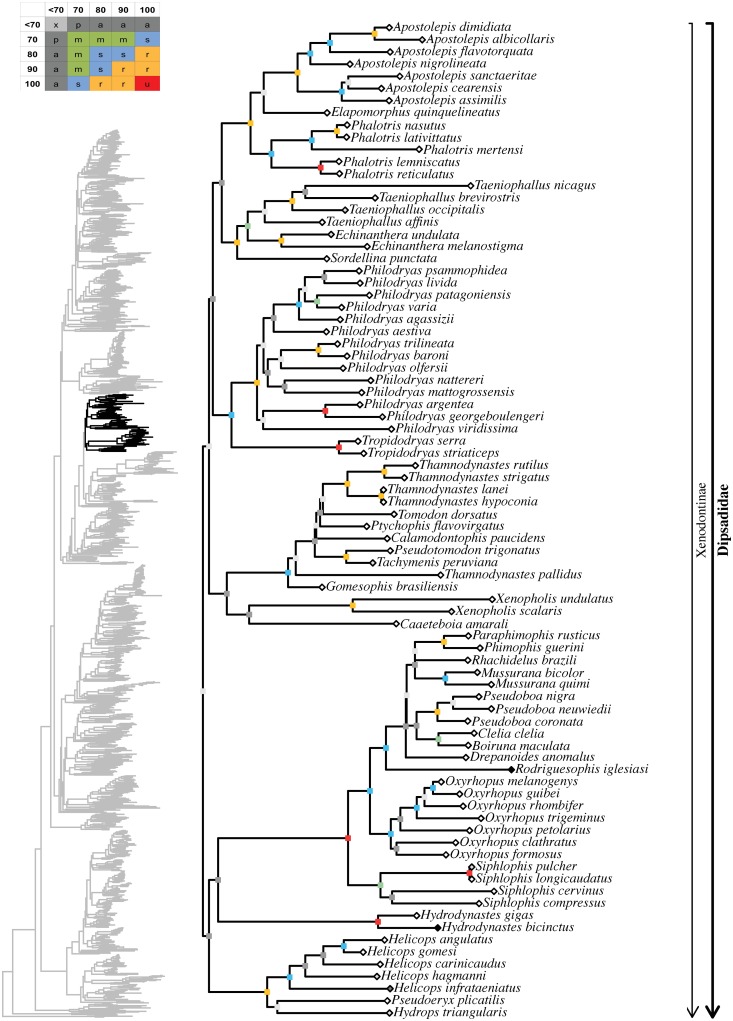
Maximum likelihood species-level phylogeny of Colubroides
(continued).Family Dipsadidae (continued).